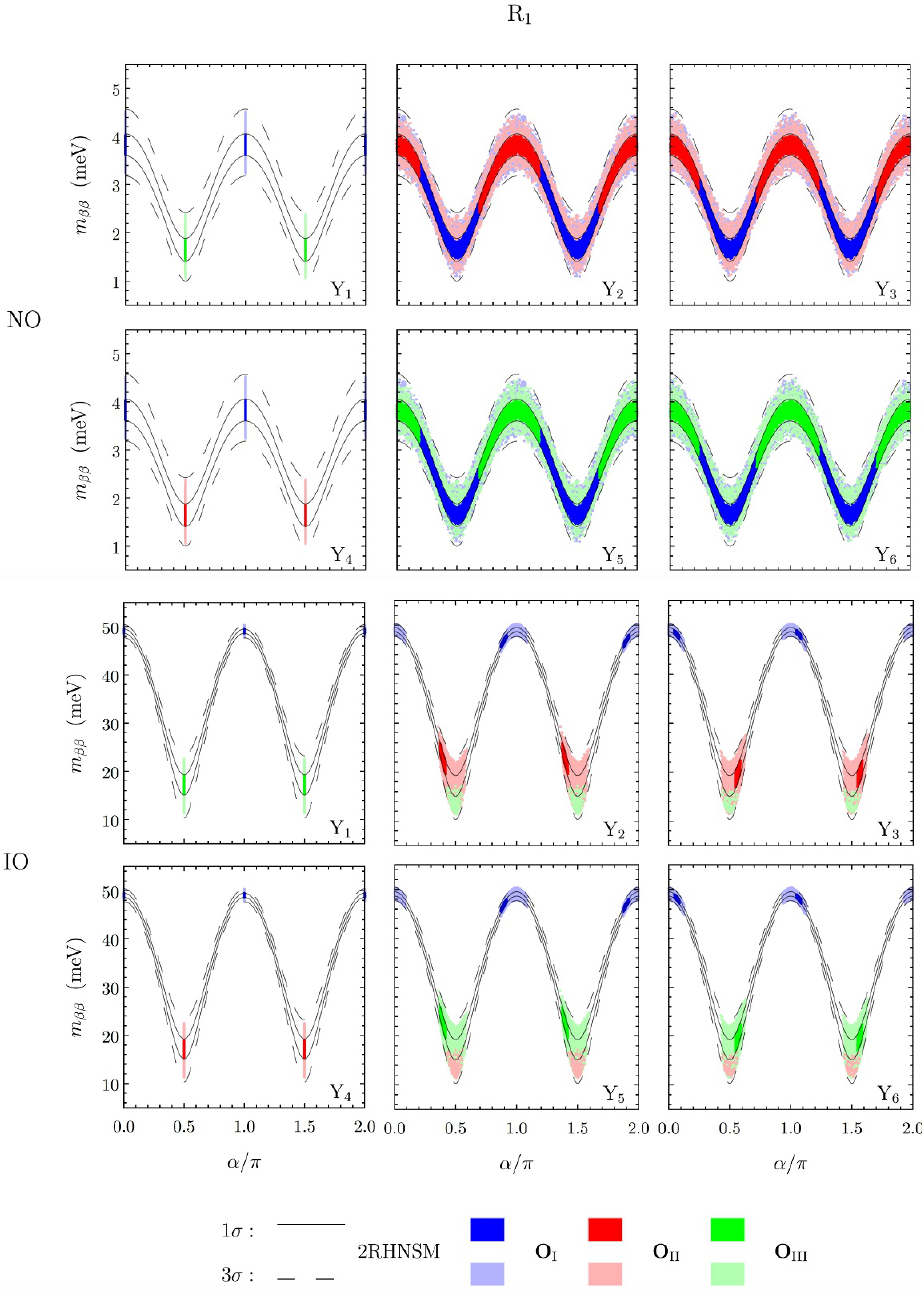
Figure 6 . Allowed regions in the ( (cid:11) , m (cid:12)(cid:12) ) plane for all (R 1 ,Y 1 (cid:0) 6 ) combinations, both for NO (upper plots) and IO (lower plots). The light (dark) coloured points were obtained varying (cid:18) ij , (cid:1) m 2 and (cid:14) within the 3 (cid:27) (1 (cid:27) ) experimental ranges given in table 1. In blue, red and green ij we show the results for the cases in which O is of the type O I , O II and O III , respectively. The solid (dashed) lines are the contours of the 1 (cid:27) (3 (cid:27) ) m (cid:12)(cid:12) regions allowed by the general 2RHNSM previously shown in (cid:12)gure 5.